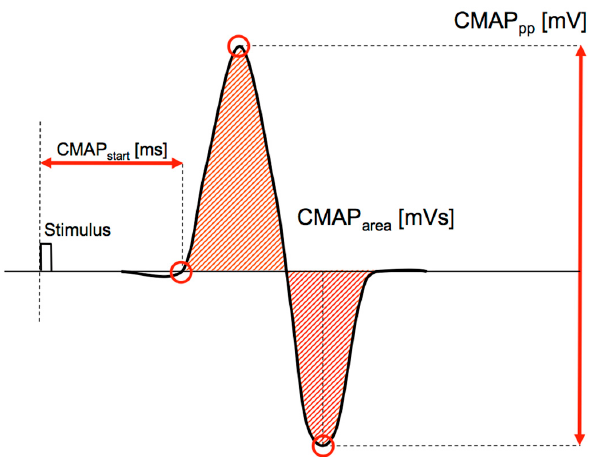
Figure 4. A simulated biphasic waveform of an MEP. The different parameters of the signal represents the main issues defining the influence on cortico-spinal excitability. The initial negative phase of the MEP (left side) is not considered in this calculation.